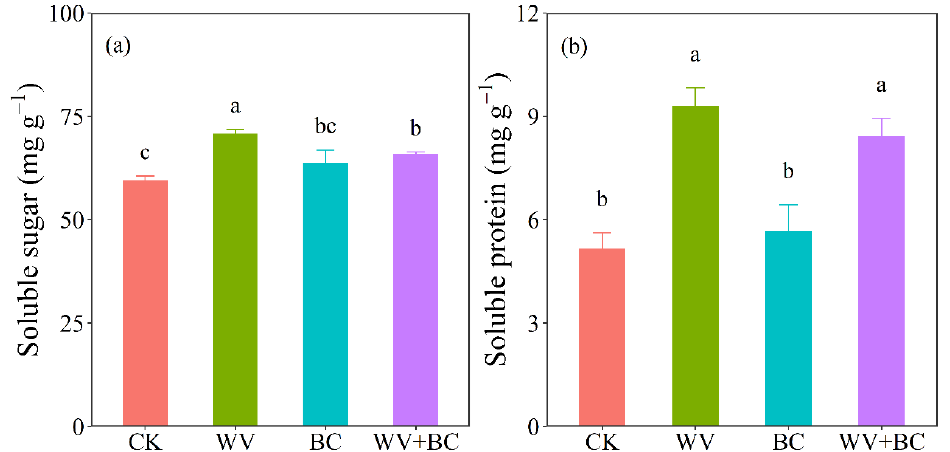
Figure 7. Effects of different seed treatments on ( a ) soluble sugar and ( b ) soluble protein of WDR at heading stage under field experiment. Different letters show a significant difference between treatments at p = 0.05 according to LSD test. Error bars indicate standard error of three replicates. CK: untreated seeds, WV: wood vinegar seed priming, BC: biochar seed coating, WV + BC: co-treatment of wood vinegar priming and biochar coating. Agronomy 2022 , 12 , x FOR PEER REVIEW